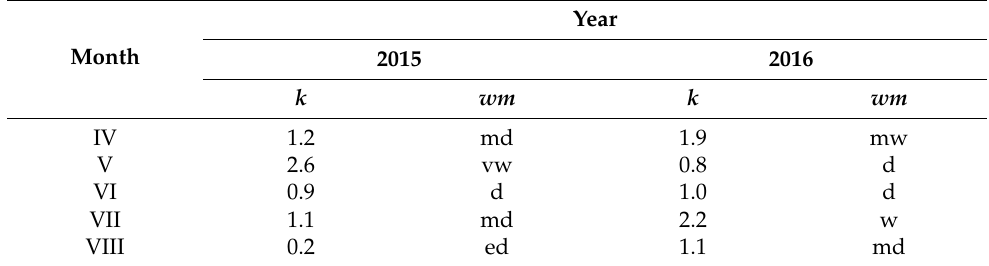
Table 3. Values of the Selyaninov hydrothermal index ( k ) during the vegetation periods of pea and spring barley and moisture characteristics ( wm ) of individual